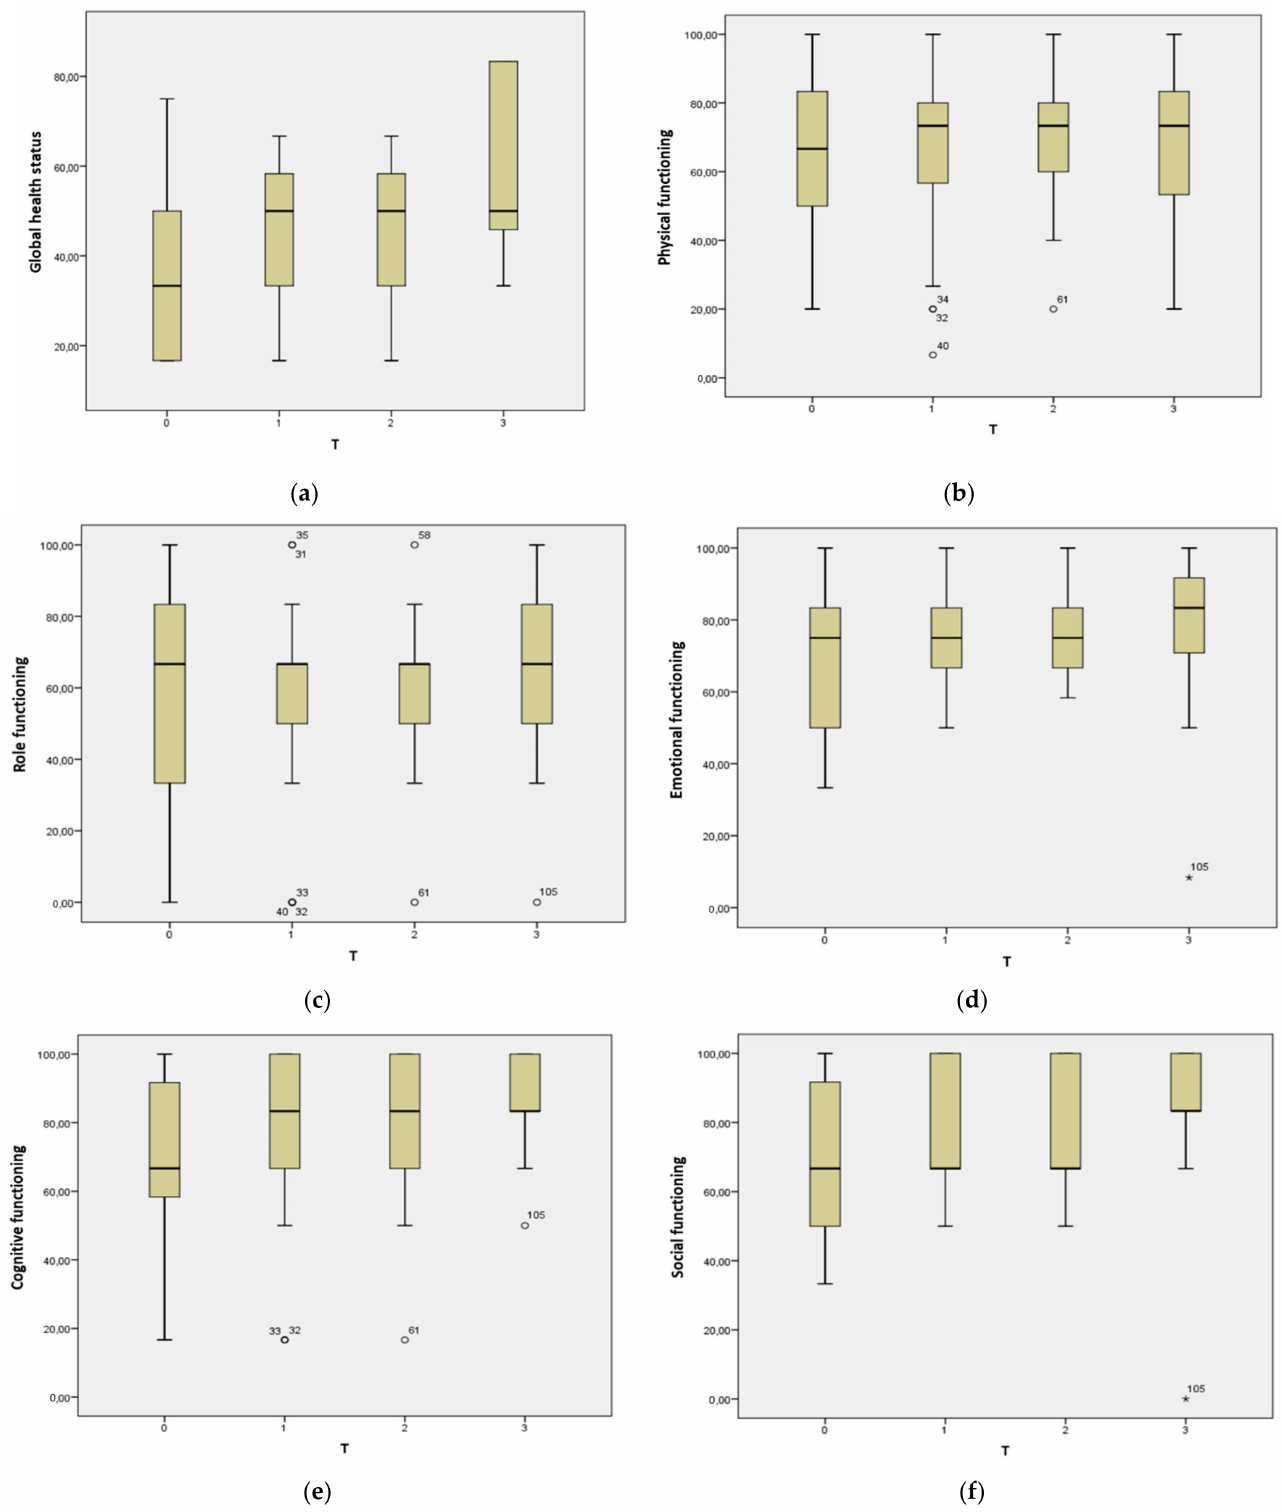
Figure 2. EORCT QLQ-C30 functional scales: ( a ) Global health status; ( b ) Physical functioning; ( c ) Role functioning; ( d ) Emotional functioning; ( e ) Cognitive functioning; ( f ) Social functioning. Post-hoc tests showed significant differences between T0 and T3 for global health status and social functioning ( p < 0.05). ◦ and * indicate